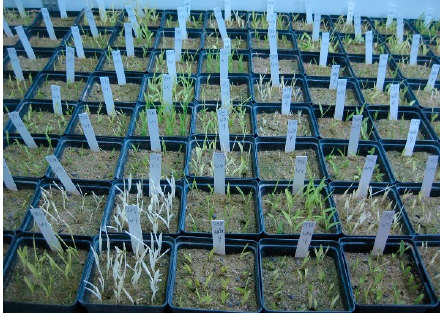
Figure 8. Di ff erential reaction of the inbred lines to constant 13 / 10 ◦ C for four weeks shows the high Figure 8. Differential reaction of the inbred lines to constant 13/10 °C for four weeks shows the high variation for cold tolerance in the diversity set variation for cold tolerance in the diversity set studied.